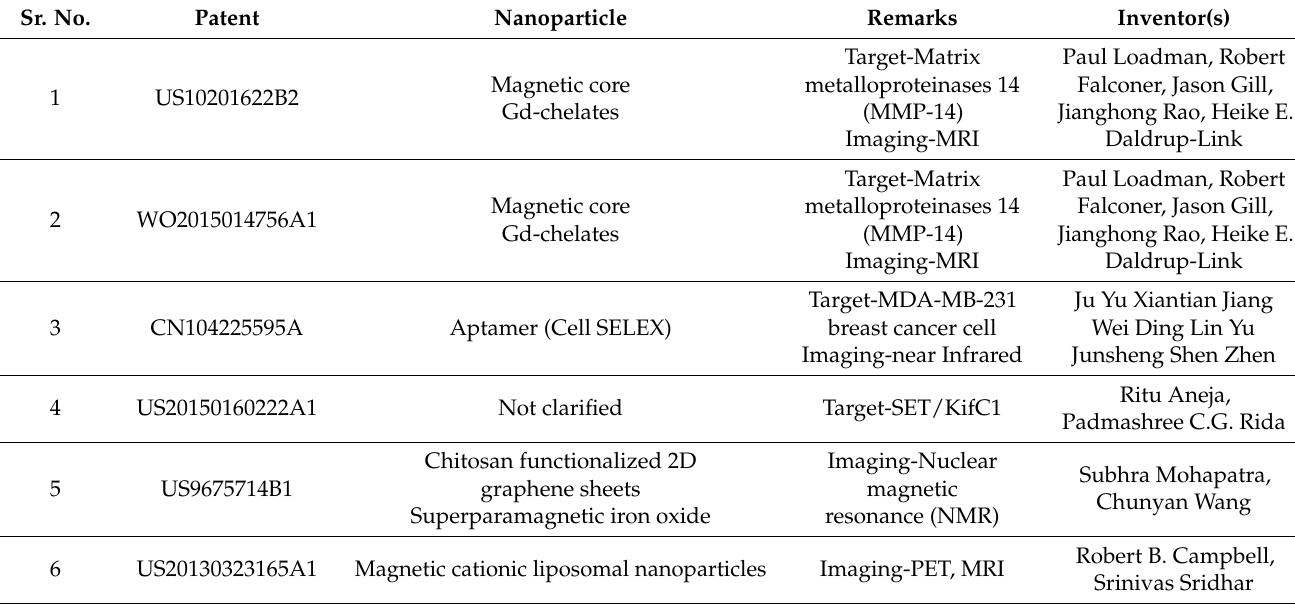
Table 2. Patents dedicated to theranostic approaches in breast